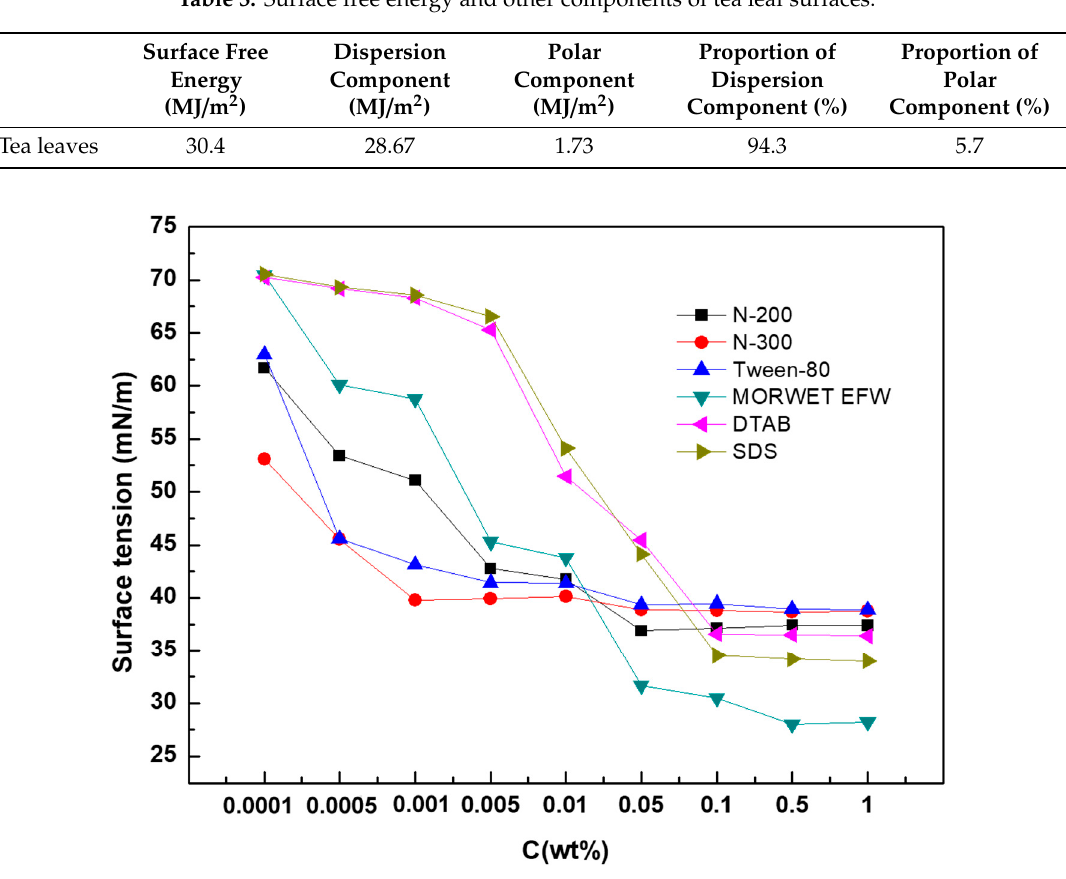
Figure 3. The relationship between the values of the contact angle ( θ ) on tea leaf surfaces and the surfactant concentration ( C , wt%).